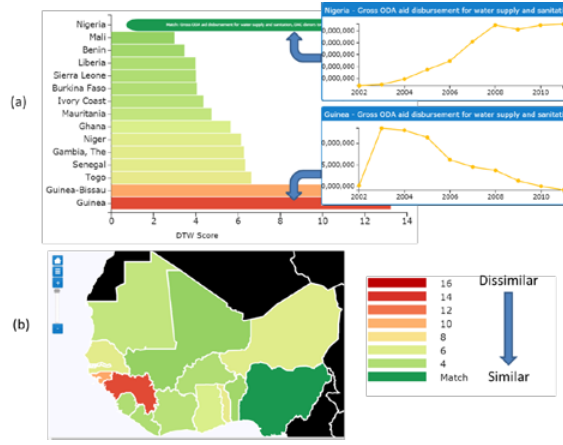
Figure 12. Similarity to Nigerian Foreign Aid: a) Bar chart of DTW similarity scores, b) map of scores